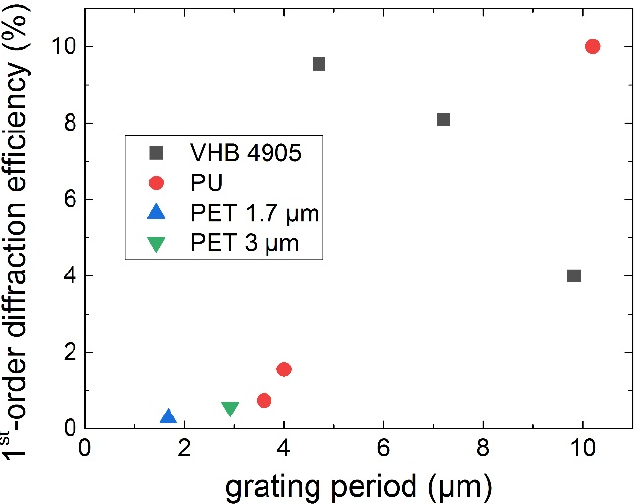
Figure 8. Experimentally measured 1st-order optical diffraction efficiency of the bulk shrinkable PU, PET and VHB 905 diffraction gratings at the 633 nm wavelength versus the grating periods.